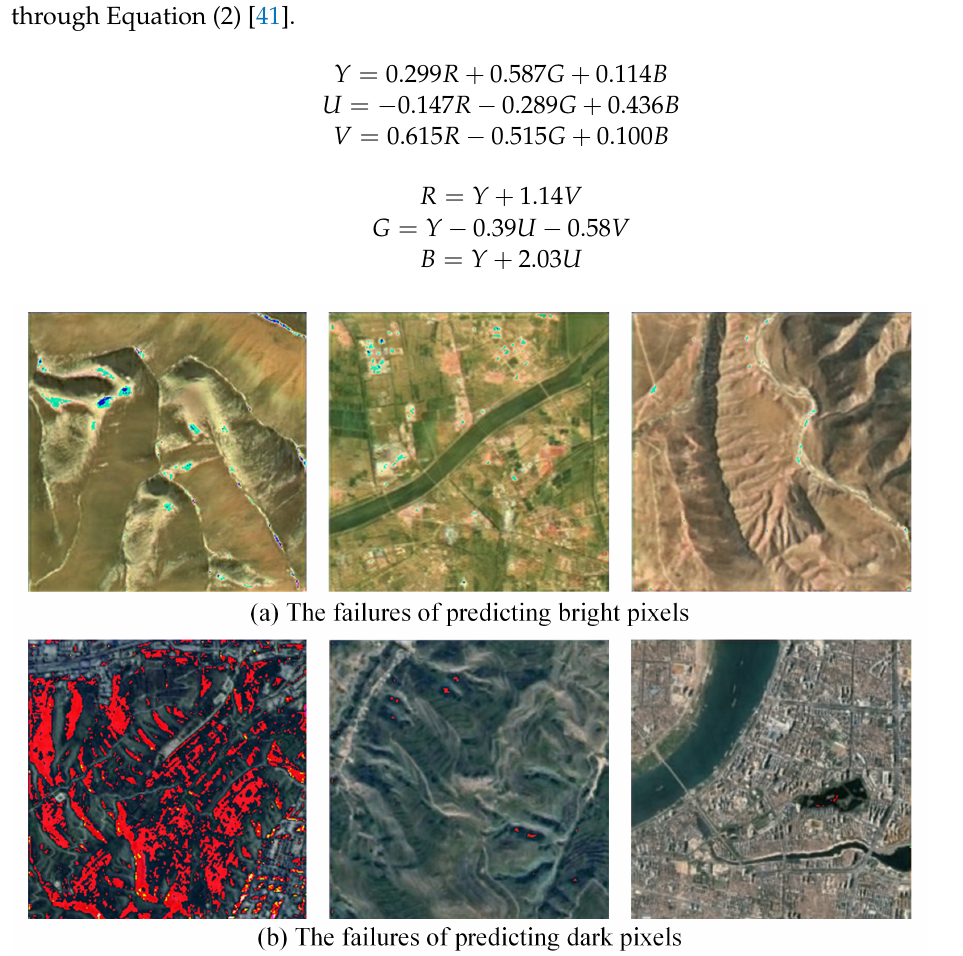
Figure 2. The failures of RSC-Net when predicting cloud-free images with some bright and dark pixels. Bright pixels are predicted to be turquoise and dark pixels are predicted to be